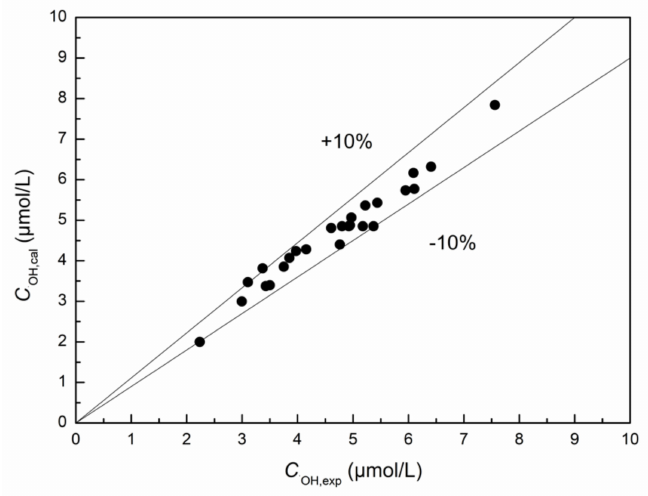
Figure 9. Comparison of experimental and calculated values for · OH